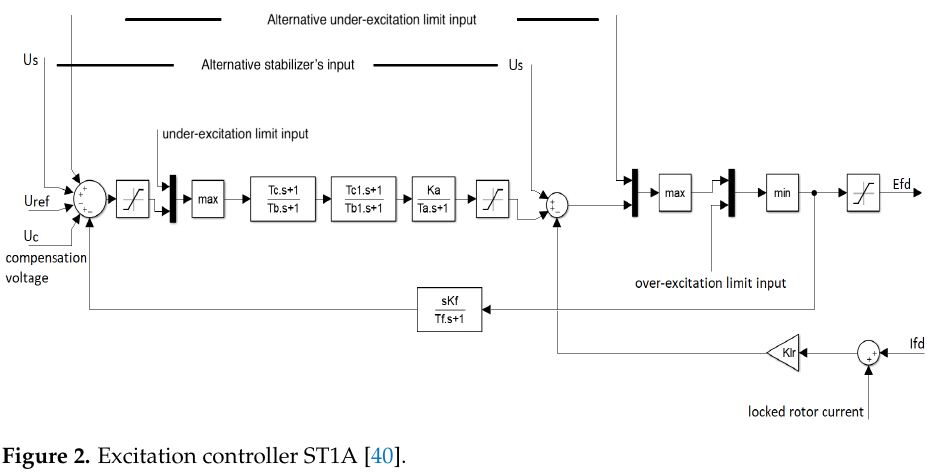
Figure 2. Excitation controller ST1A [40].